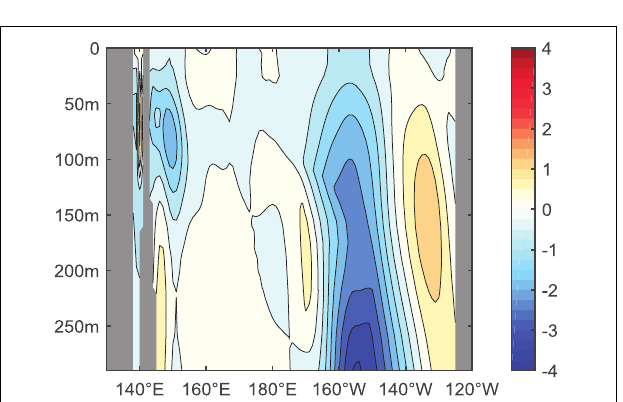
FIGURE 3 | The ocean temperature changes along 45 ◦ N in the North Pacific as the EAKF scheme compared with the Projection-OI assimilation scheme. This change was calculated according to Eq. (4) for 1993–2017 (units: ◦ C). The negative value indicates improvement with EAKF data